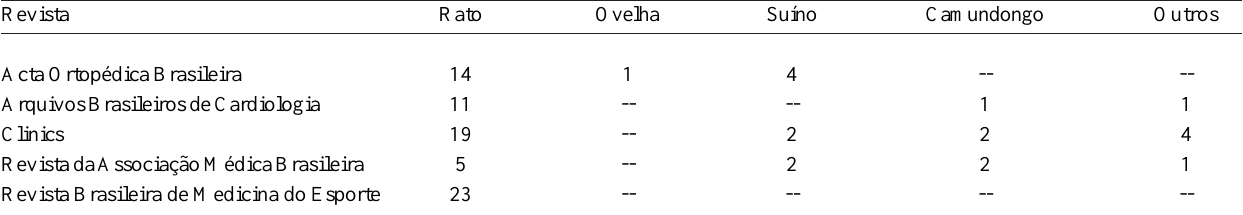
Tabela 3. Animal utilizado nos artigos